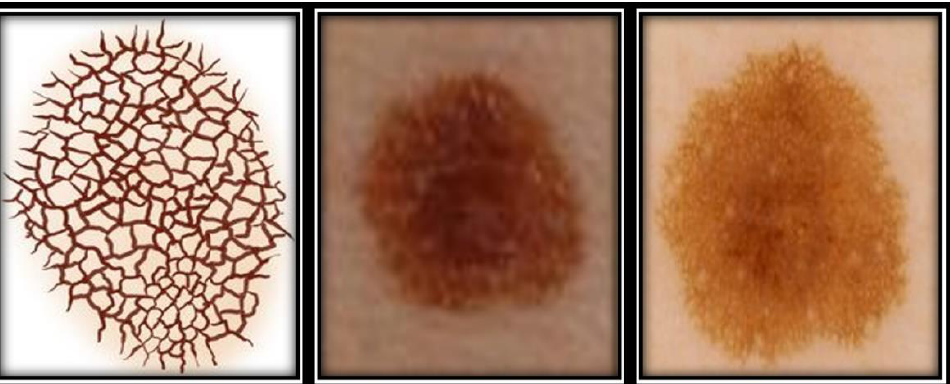
Figure 2. The t ypical pigmented network. Figure 2. The typical pigmented network.